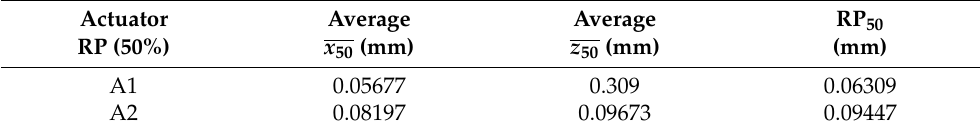
Table 6. RP 100 values calculated for actuators under the full load.